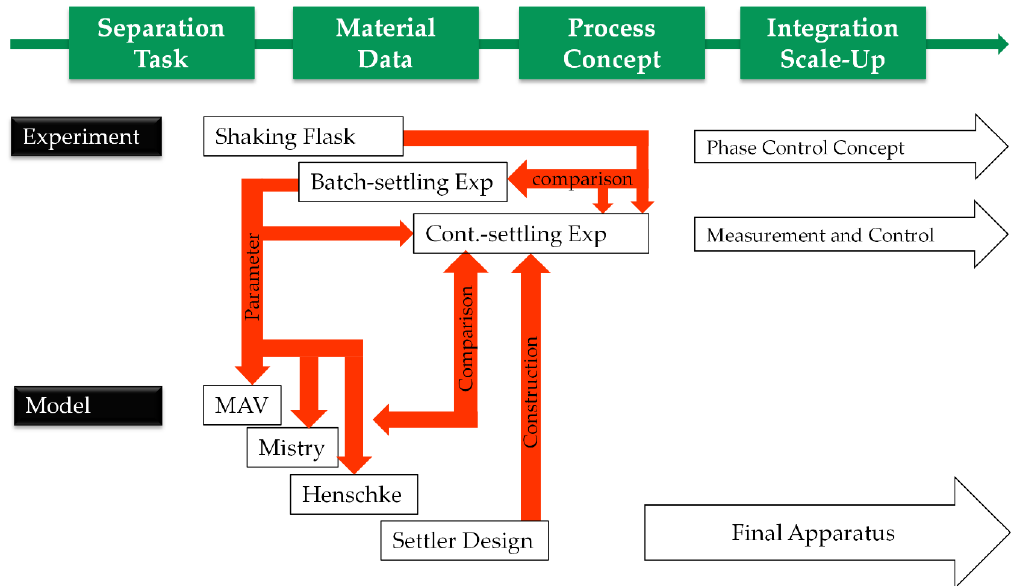
Figure 17. Process development strategy.